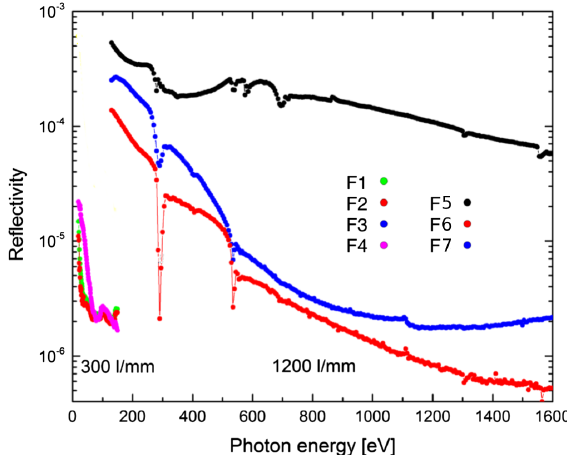
FIG. 20. Data sets Th1-Th4: scan of θ 2 for several energies, with fixed θ 1 ¼ 1 . 5 °, aluminum sample